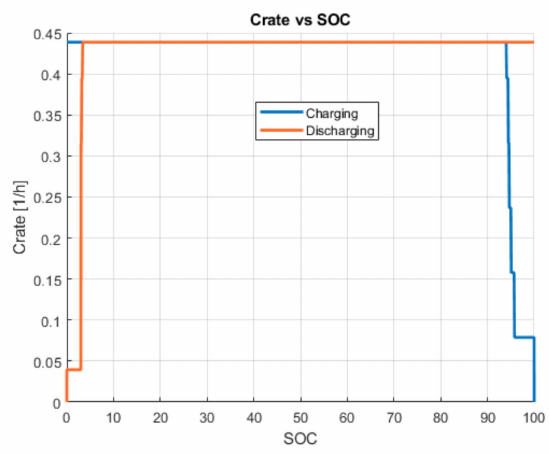
Figure 10. C-rate maximum vs.